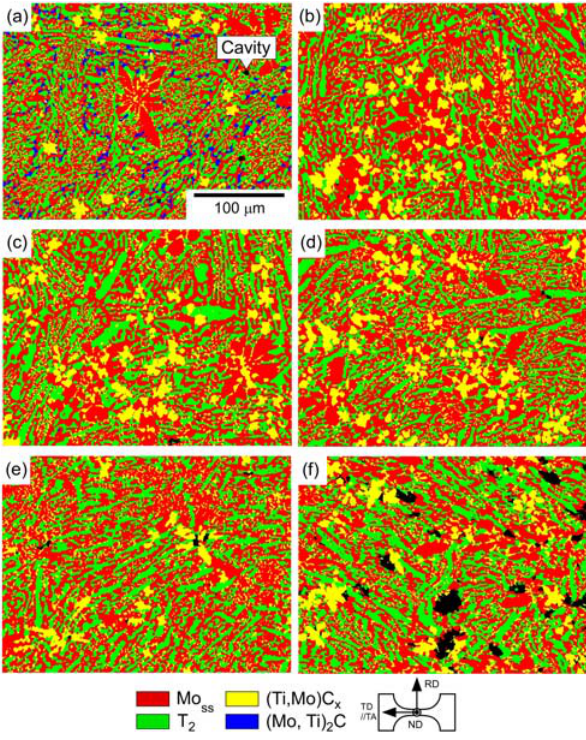
Figure 2: Phase maps of constituent phases of the MoSiBTiC alloy crept at 1,500°C and 137 MPa with creep stains of ( a ) 0%, ( b ) 3%, ( c ) 12%, ( d ) 32%, ( e ) 53%, and ( f )